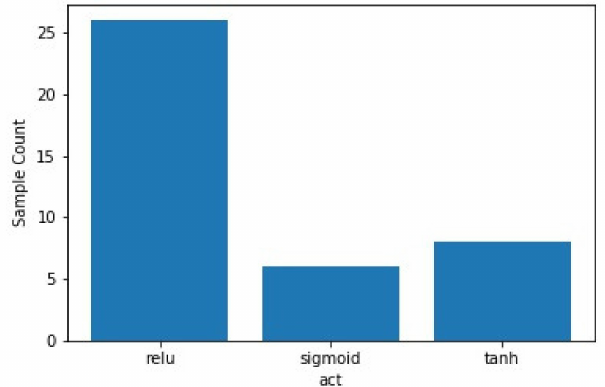
Figure 5. Sample count from the di ff erent sample of the proposed solution